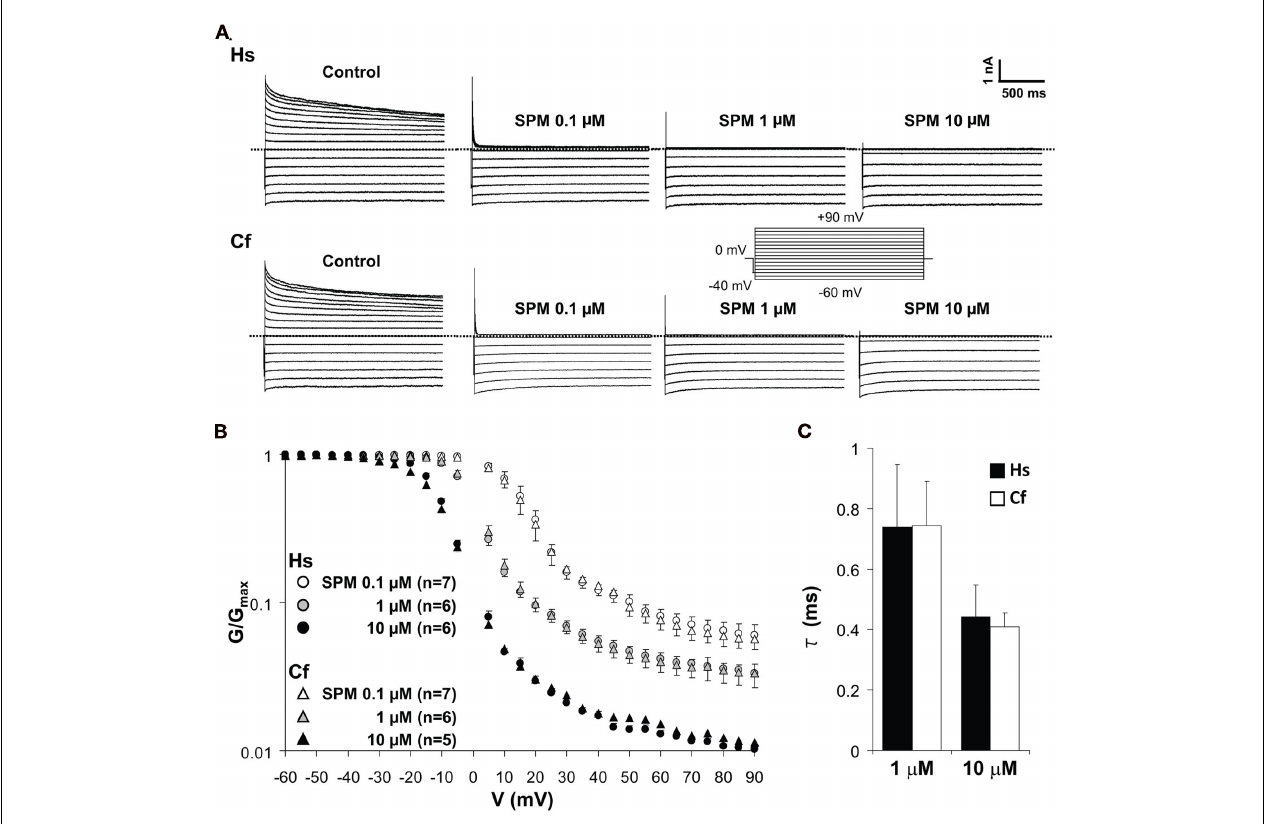
V – G relationships of human and dog K IR 2.2.The scale of G / G max is logarithmic. Test pulses were applied in 5mV steps from − 60 to + 90mV, and G was calculated for each voltage. (C) The comparison of time constant of K IR 2.2 channel currents at + 80mV in the presence of 1 and 10 μ M